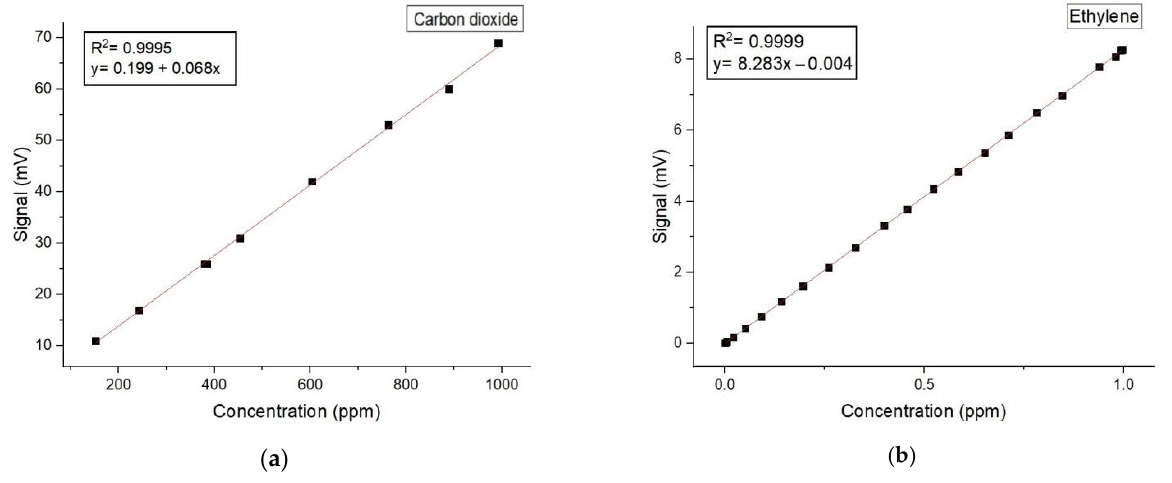
Figure 2. The concentration-dependent response for ( a ) carbon dioxide and ( b ) ethylene.